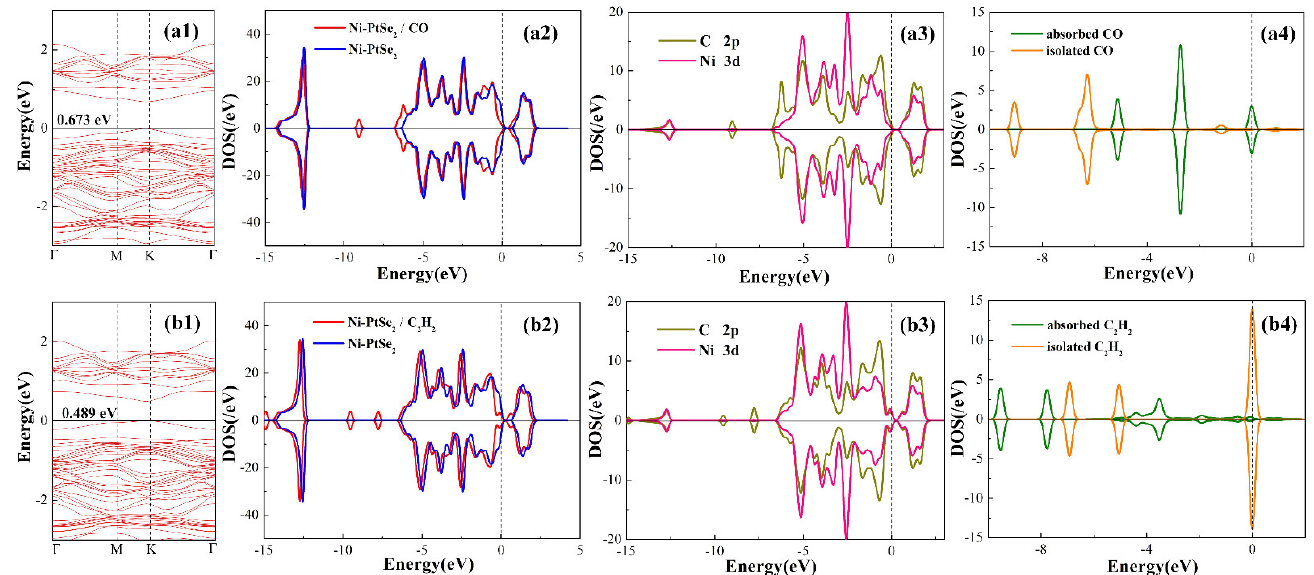
Figure 6. BS and DOS of ( a1 − a4 ) CO system and ( b1 − b4 ) C 2 H 2 system. The dashed line is Fermi level.